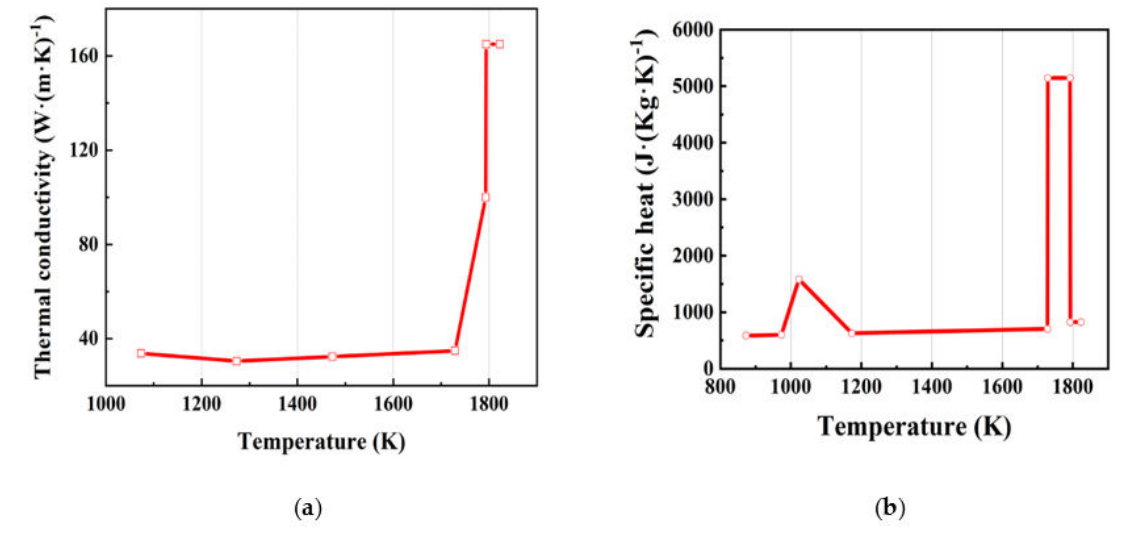
Figure 2. ( a ) Thermal conductivity of Q235 steel; ( b ) the specific heat of Q235